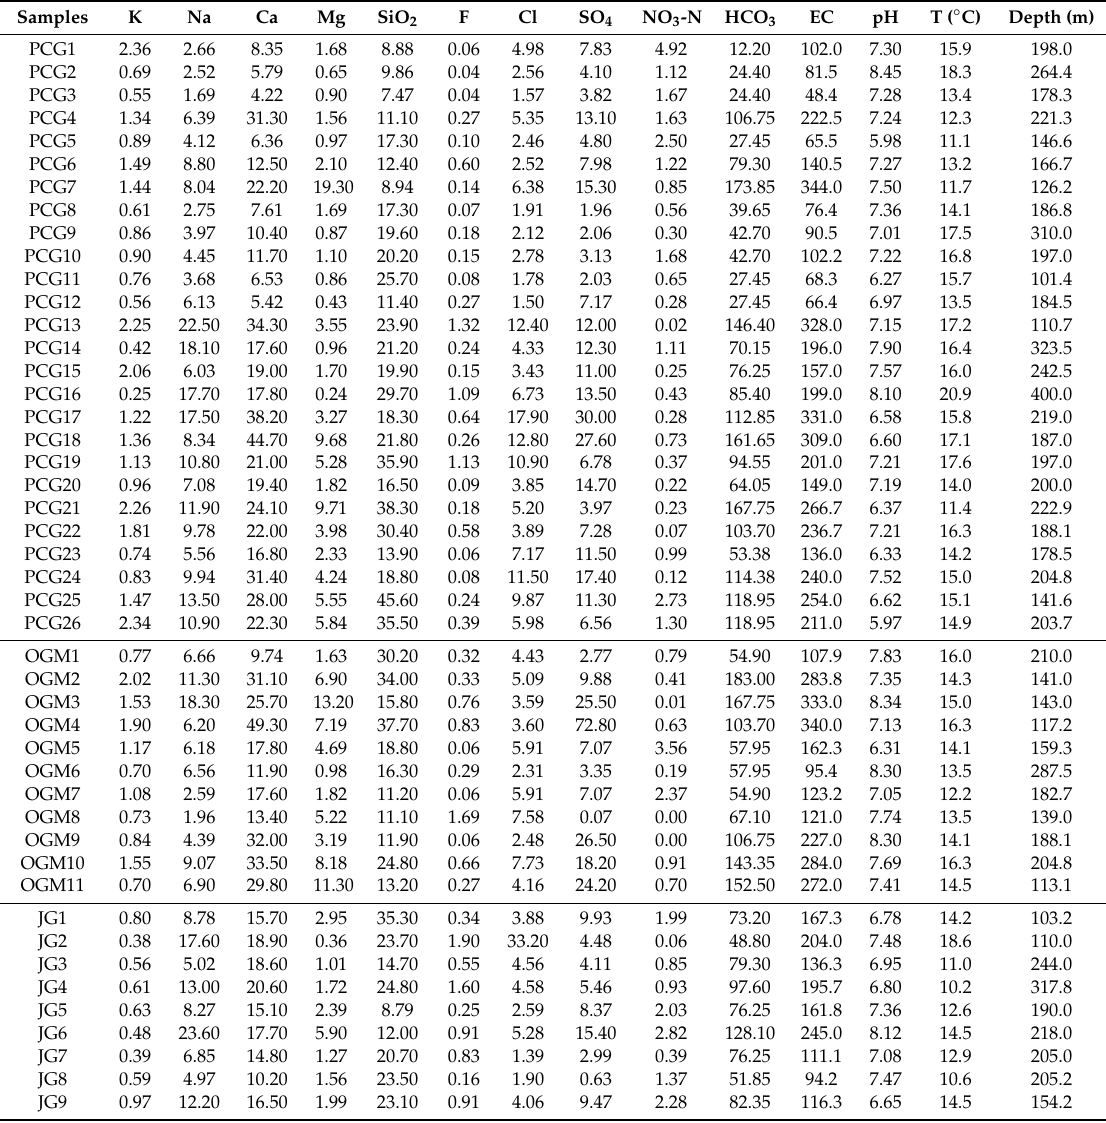
Table 1. Physicochemical compositions in groundwater for bottled waters. Concentration unit is mg /